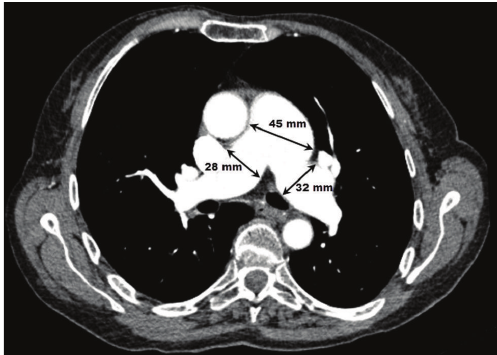
Figure 2: Computerized tomography of the chest showing large PA dilatation involving the main PA and its branches. PA: pulmonary